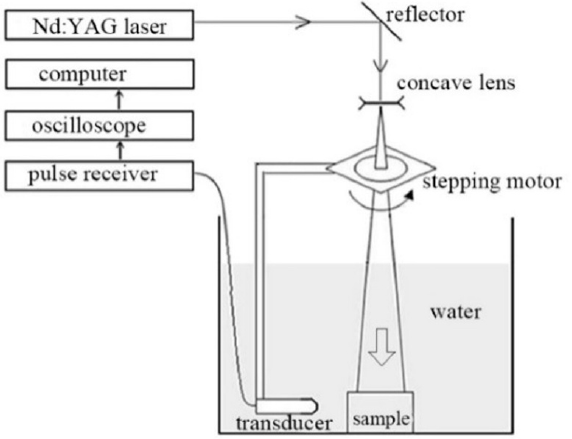
Figure 11. Scheme of the platform used for the experiments.